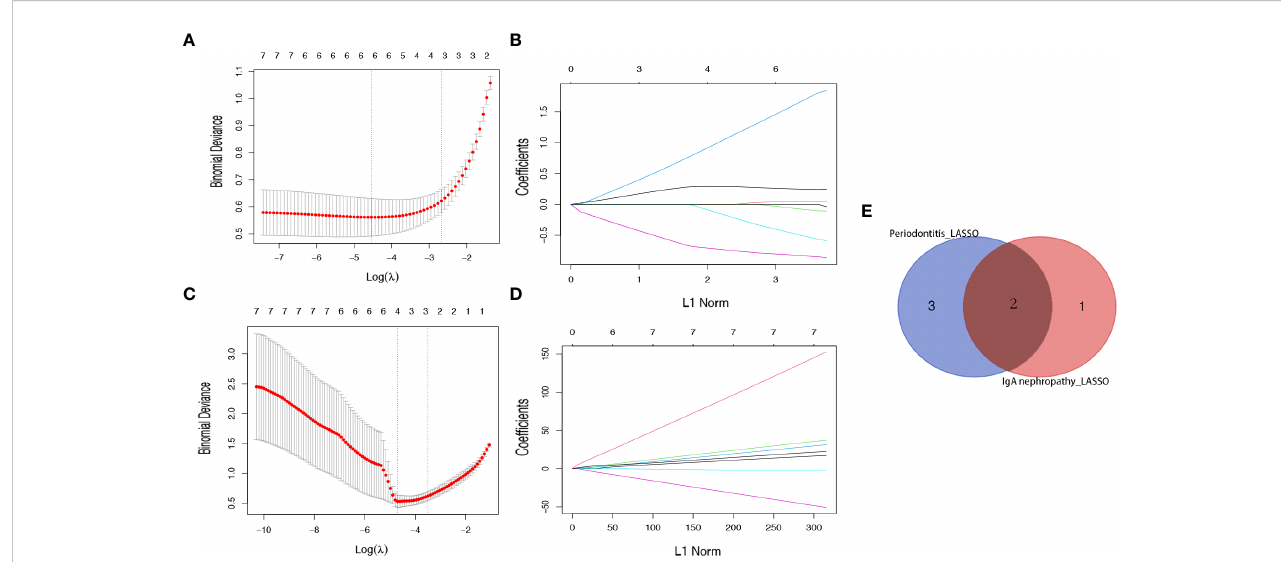
FIGURE 5 Identi fi cation of potential shared diagnostic genes by the LASSO regression model. (A) Tenfold cross-validation to select the optimal tuning parameter log (lambda) in the GSE16134 database. (B) Tenfold cross-validation to select the optimal tuning parameter log (lambda) in the GSE93798 database. (C) LASSO coef fi cient pro fi les of diagnostic genes in the GSE16134 database. (D) LASSO coef fi cient pro fi les of diagnostic genes in the GSE93798 database. (E) Venn diagram showing the optimal diagnostic